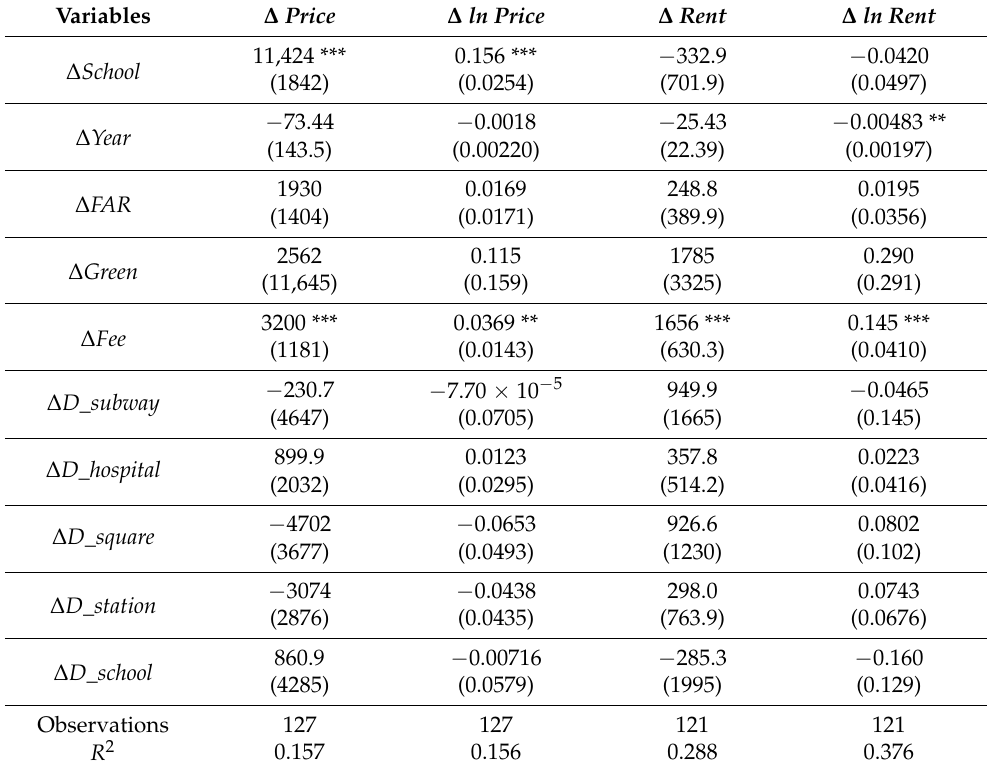
Table 4. Results of paired difference